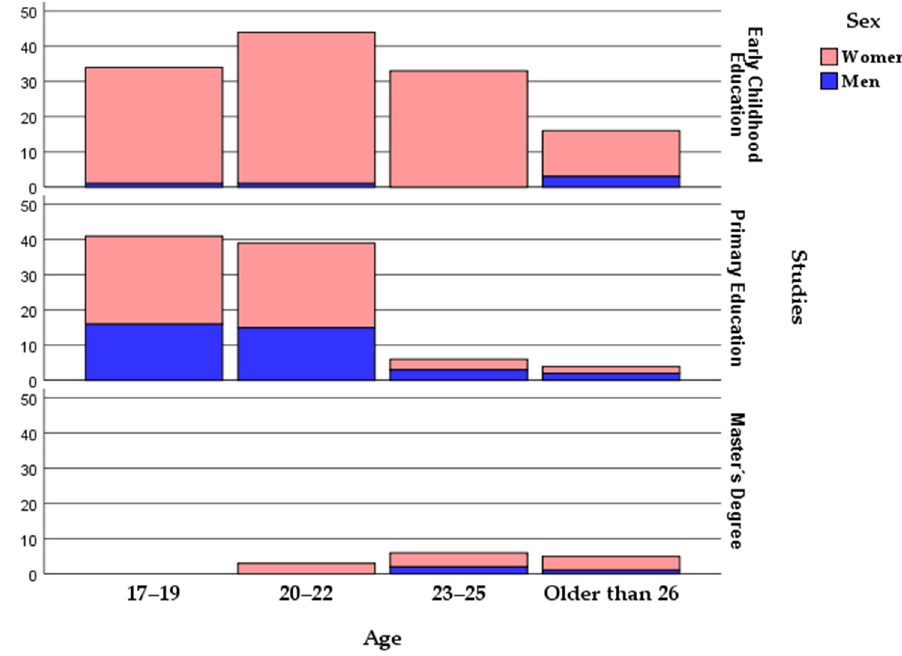
Figure 2. Percentages of the variable sex, age, and degree.